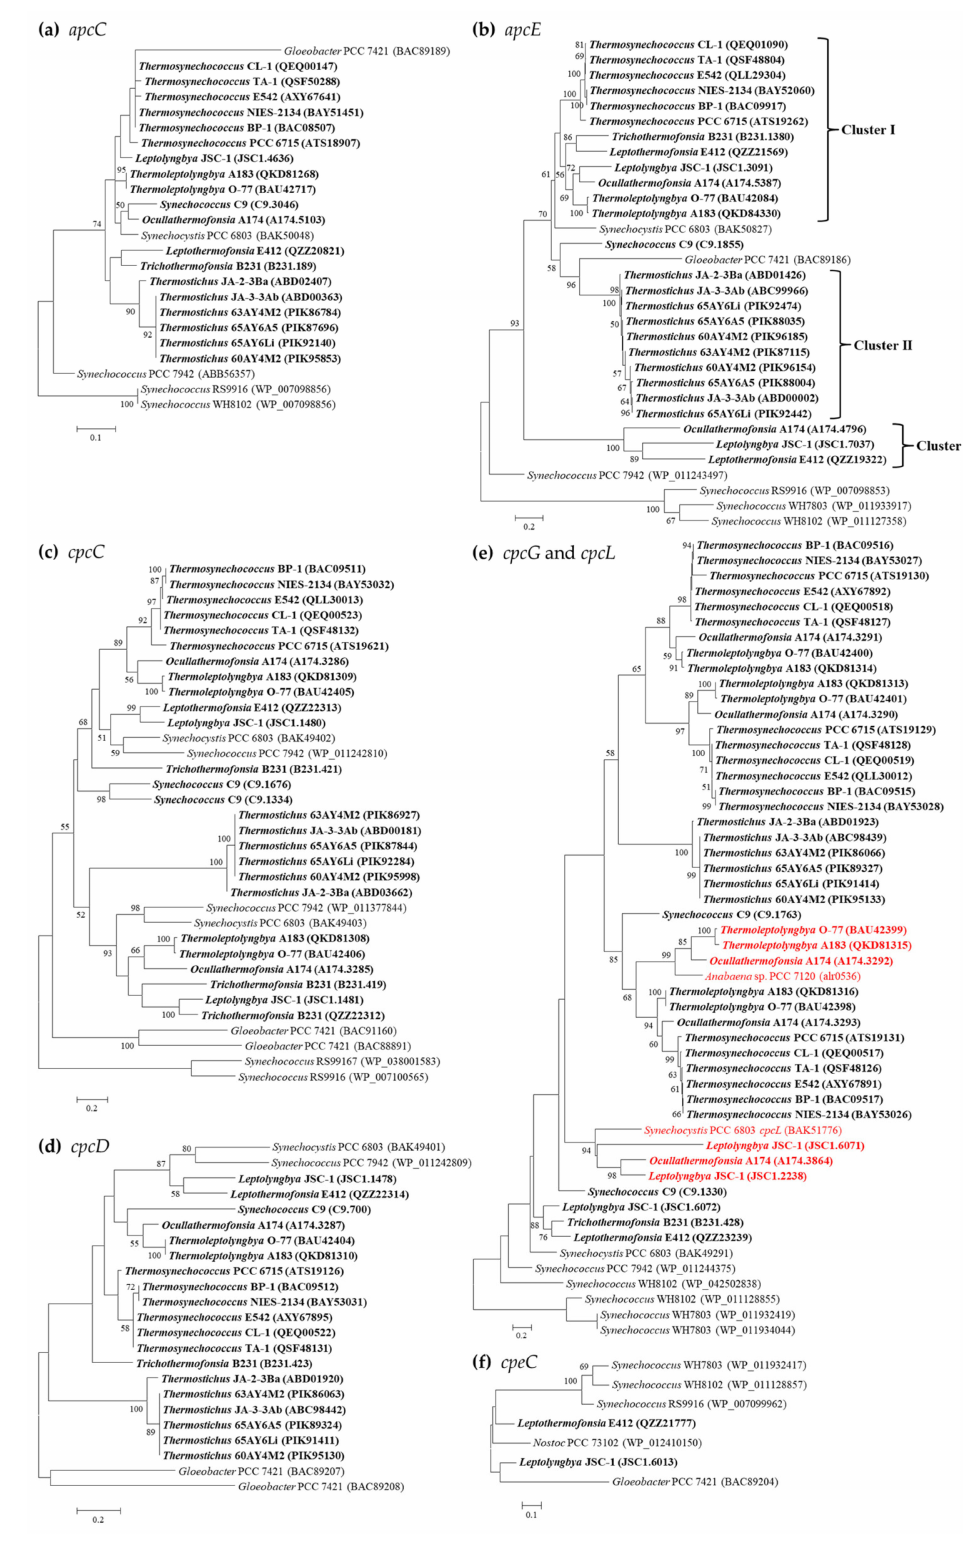
Figure 2. Phylogenetic inference of protein sequences encoding linker polypeptides. The thermophilic cyanobacteria surveyed in this study are indicated in bold. The putative cpcL is indicated in red. Only bootstrap values > 50% are indicated at nodes. ( a ) apcC , ( b ) apcE , ( c ) cpcC , ( d ) cpcG and cpcL , ( e ) cpcD , ( f ) cpeC